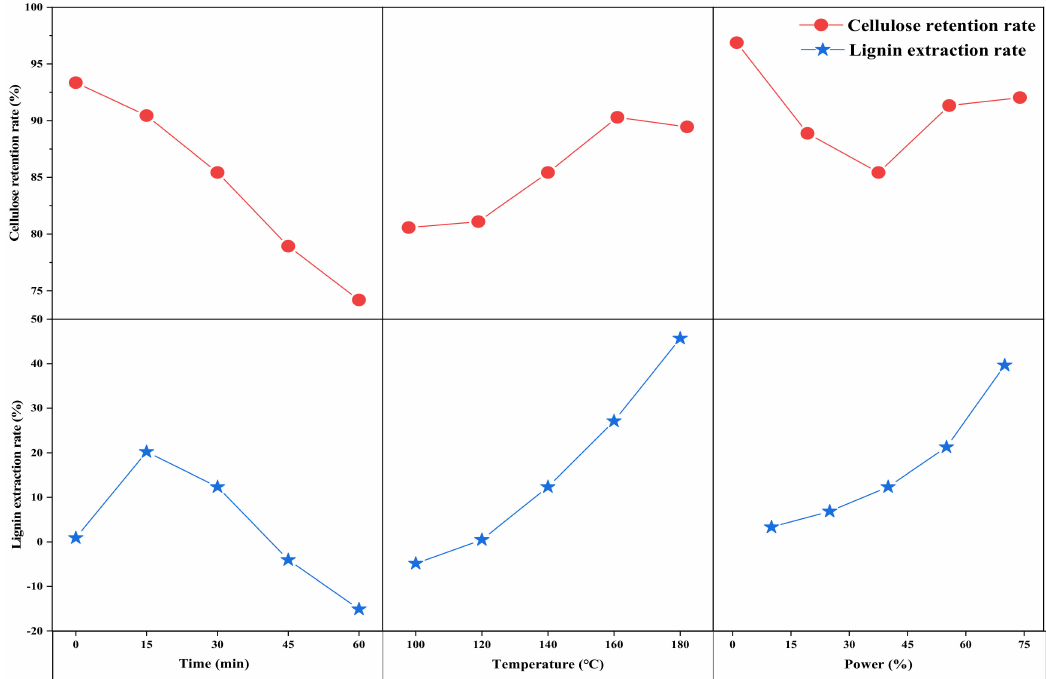
Figure 3. Lignin removal and cellulose retention of solid